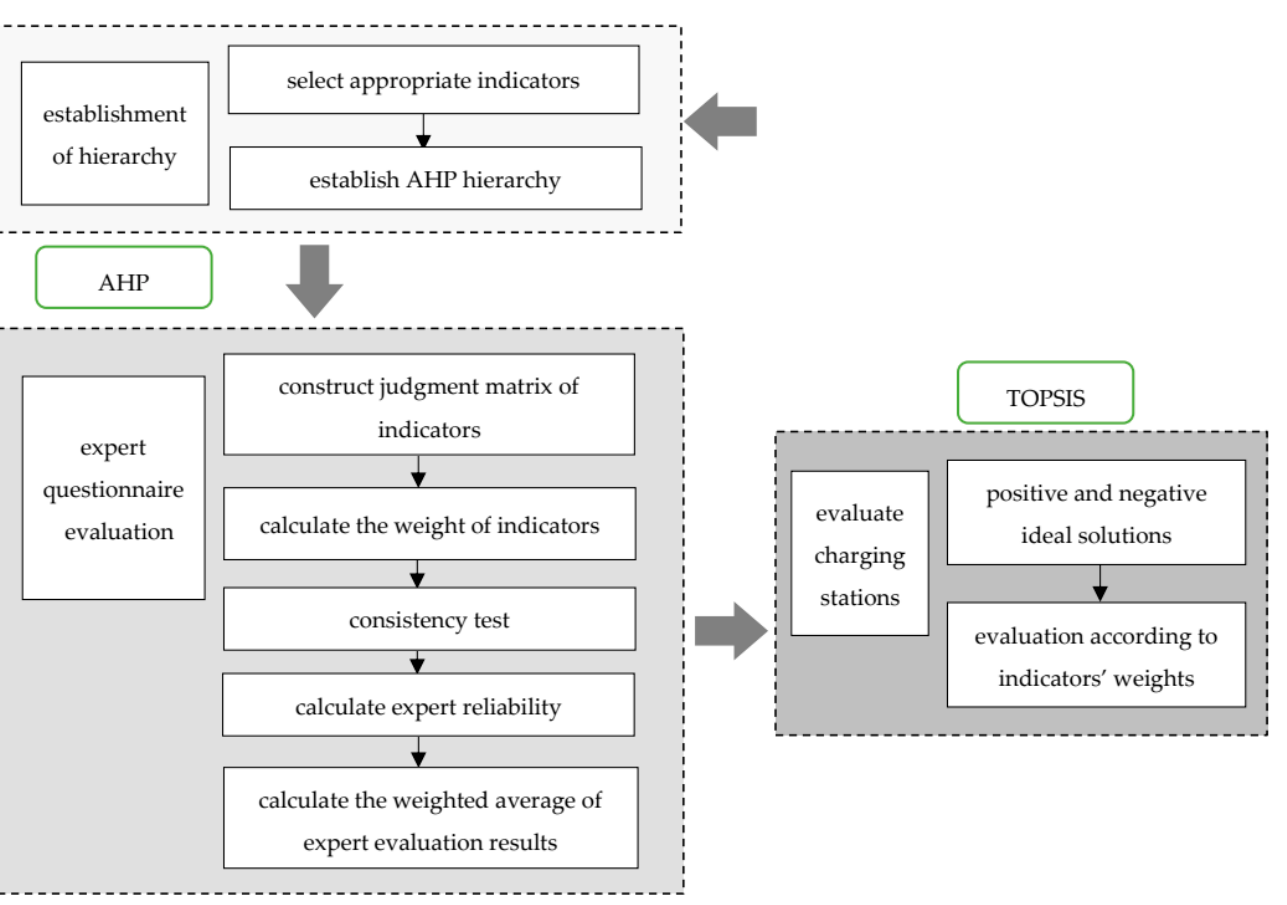
Figure 1. Framework of the research methodology.